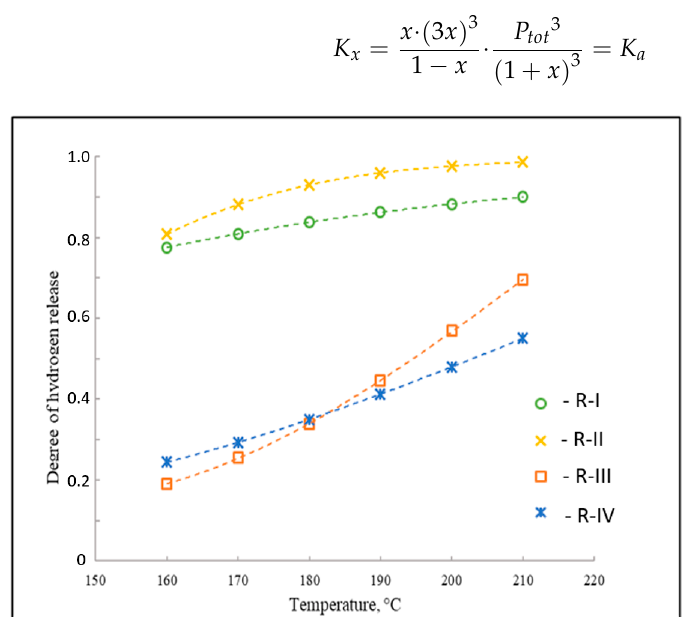
Figure 6. Degree of H 2 release in the dehydrogenation of individual reactions in the LOHC system 1-methylindole/octahydro-1-methylindole, as referenced to reactions R-I to R-IV given in Figure 2.